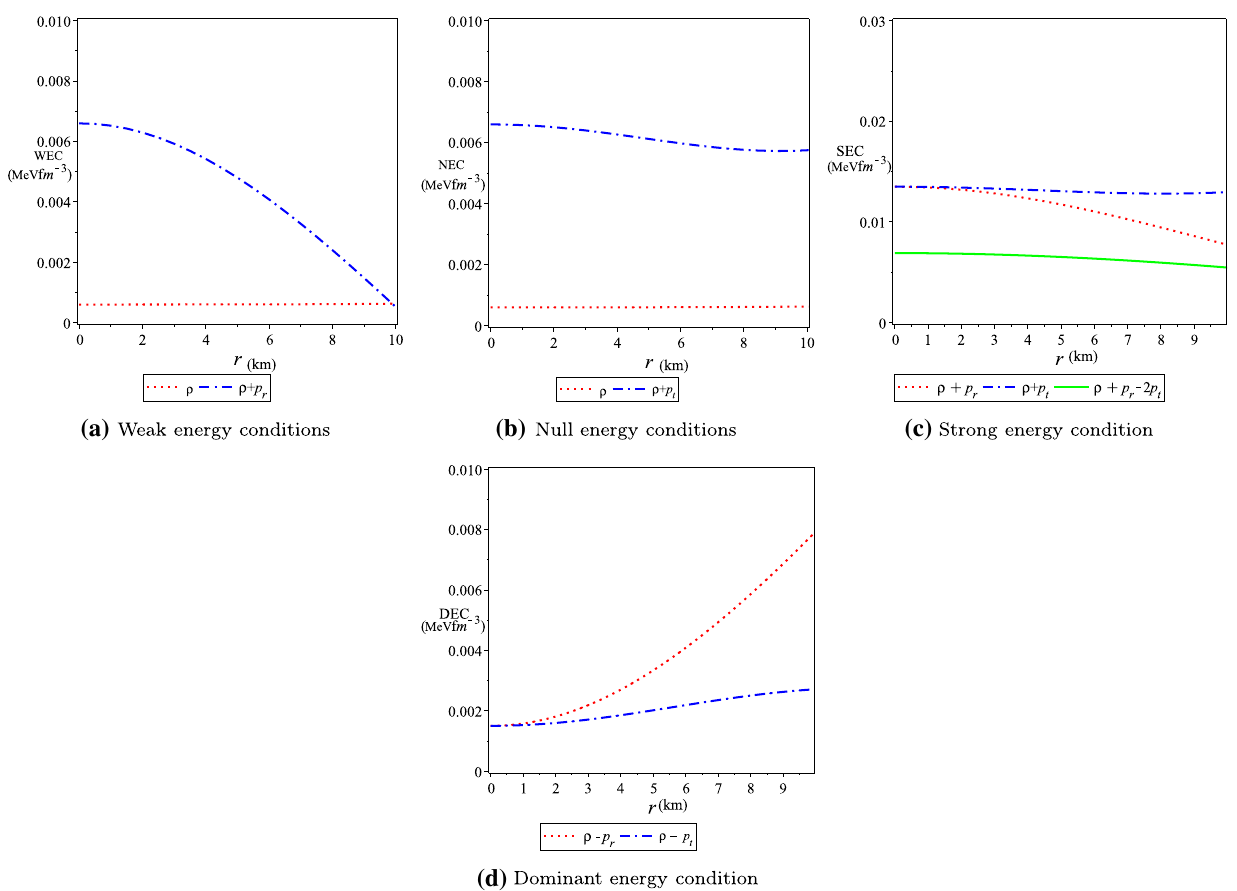
Fig. 6 Plots of the weak, null, strong and dominant energy conditions coming from (26) vs the radial coordinate r in Km using the PSR J 1614-2230 constraints matching between G ( R ) and 1 − 2 M